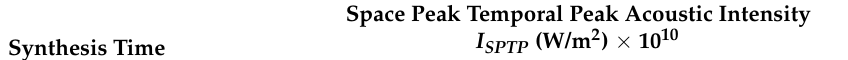
Table 2. Space peak temporal peak acoustic intensity I SPTP in S , C1 , and C2 during ultrasound- assisted synthesis of nano-ZnO.